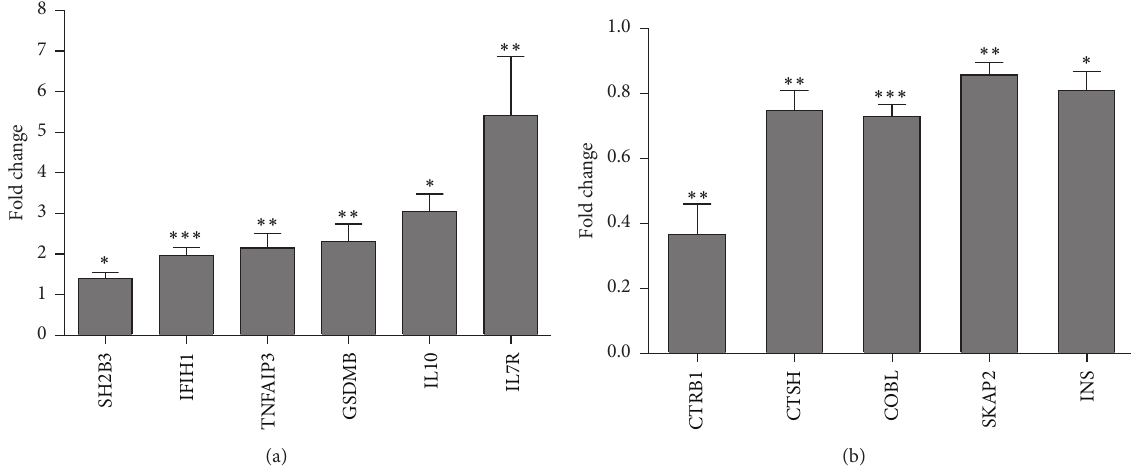
Figure 1: Cytokine-regulated candidate genes in human islets. Isolated human islets were left untreated or exposed to cytokines (IL-1 𝛽 + IFN 𝛾 + TNF 𝛼 ) for 48 h. Gene expression of candidate genes was determined by real-time PCR. Target gene expression was normalized to the geometric mean of three housekeeping genes. (a) Genes upregulated in response to cytokine treatment. (b) Genes downregulated in response to cytokine treatment. Data are means ± SEM of 𝑛 = 8-9, except for IL10 ( 𝑛 = 3 ). ∗ 𝑝 < 0.05 , ∗∗ 𝑝 < 0.01 , and ∗∗∗ 𝑝 < 0.001